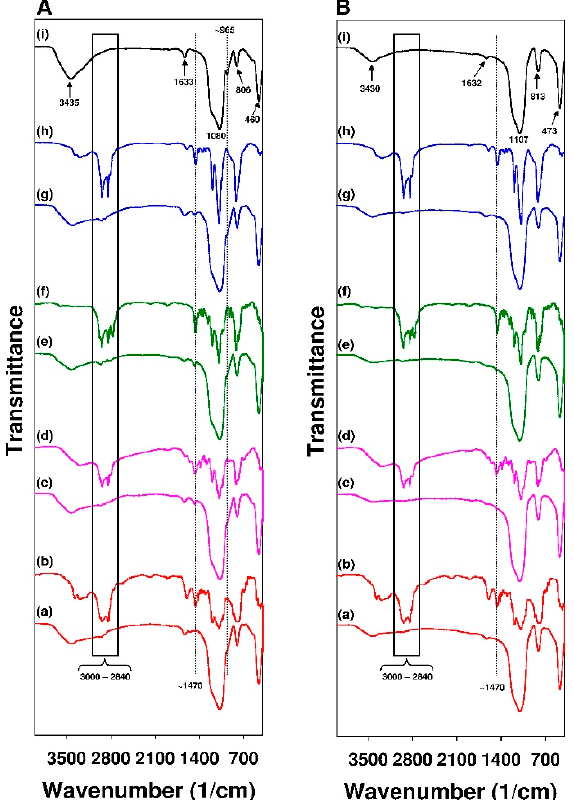
Figure 5. FT-IR spectra of ( A ) SBA-15 silicas and adequate modifying agents: ( a ) SBA-15-AP, ( b ) APTMS, ( c ) SBA-15-MAP, ( d ) MAPTMS, ( e ) SBA-15-DMAP, ( f ) DMAPTMS, ( g ) SBA-15-AEAP, ( h ) AEAPTMS, ( i ) pure SBA-15 silica; ( B ) Aerosil ® and adequate modyfying agents: ( a ) Aer-15-AP, ( b ) APTMS, ( c ) Aer-15-MAP, ( d ) MAPTMS, ( e ) Aer-DMAP, ( f ) DMAPTMS, ( g ) Aer-AEAP, ( h ) AEAPTMS, and ( i ) pure Aerosil ® .